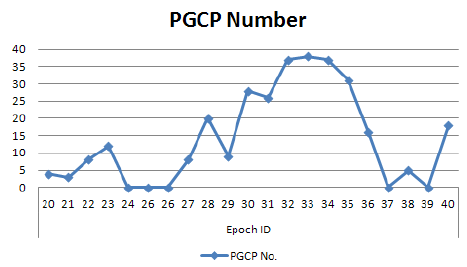
Figure 4. Number of PGCP for epoch 20-40